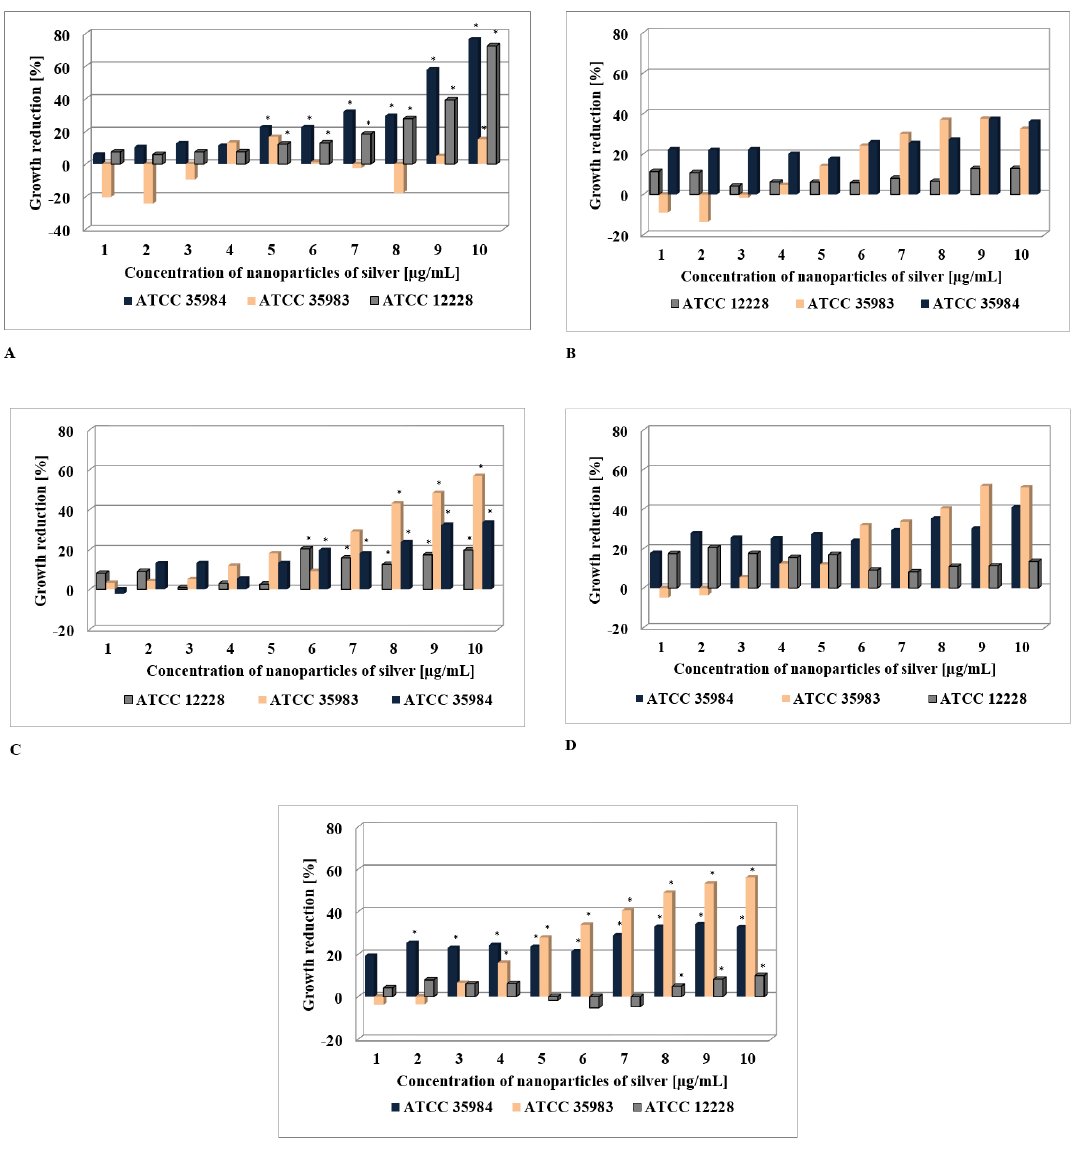
Figure 1. Growth reduction in case of S. epidermidis strains subjected to AgNPs, particle size 10 nm ( A ), 20 nm ( B ), 40 nm ( C ), 60 nm ( D ), 100 nm ( E ). The histograms provide the p -values obtained by